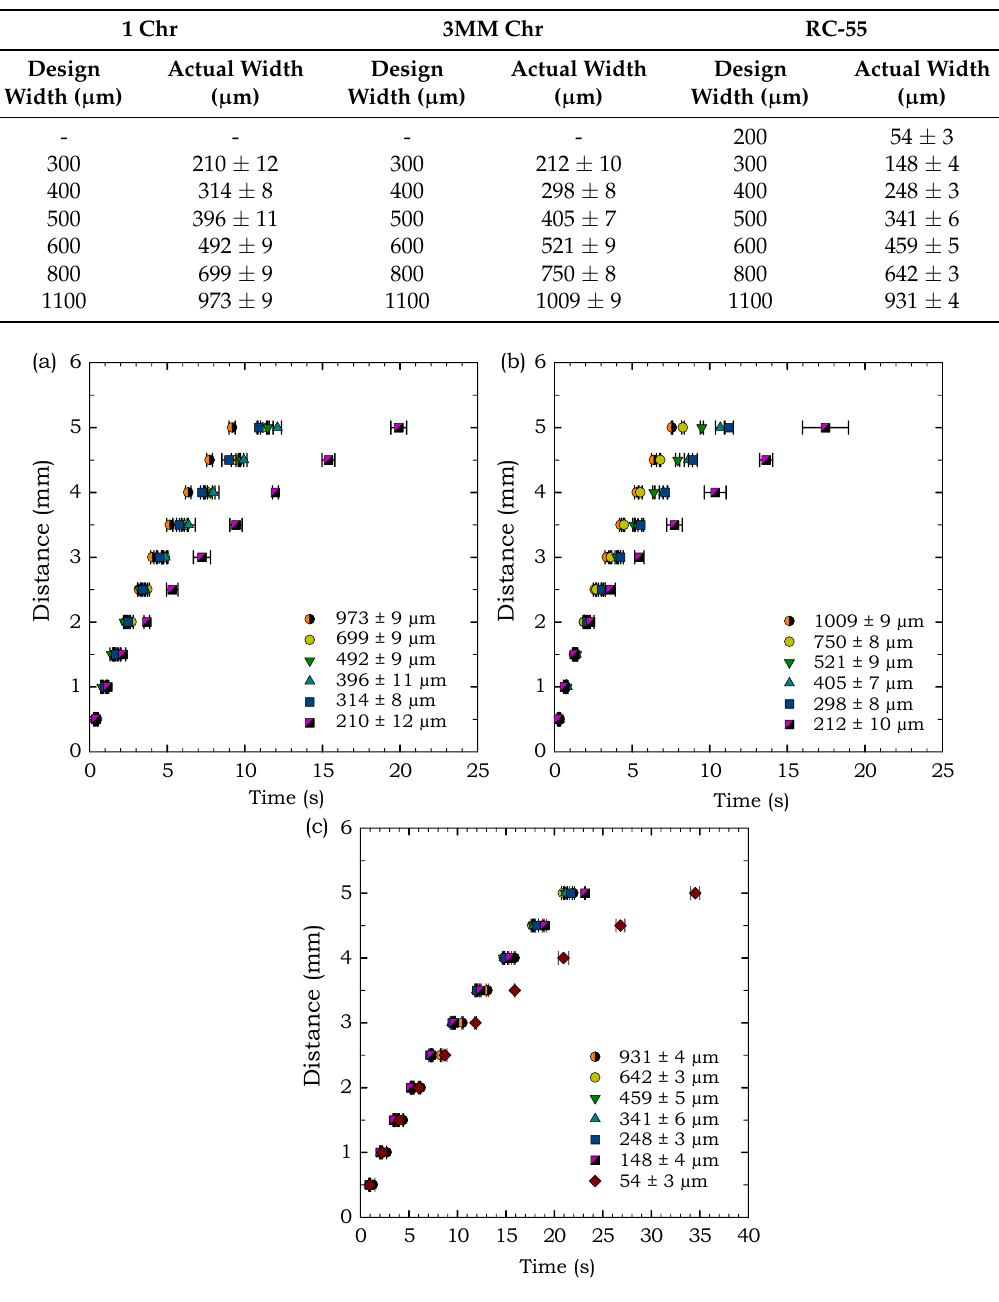
Figure 6. Flow behavior through varying channel widths fabricated in ( a ) 1 Chr, ( b ) 3MM Chr, and ( c )